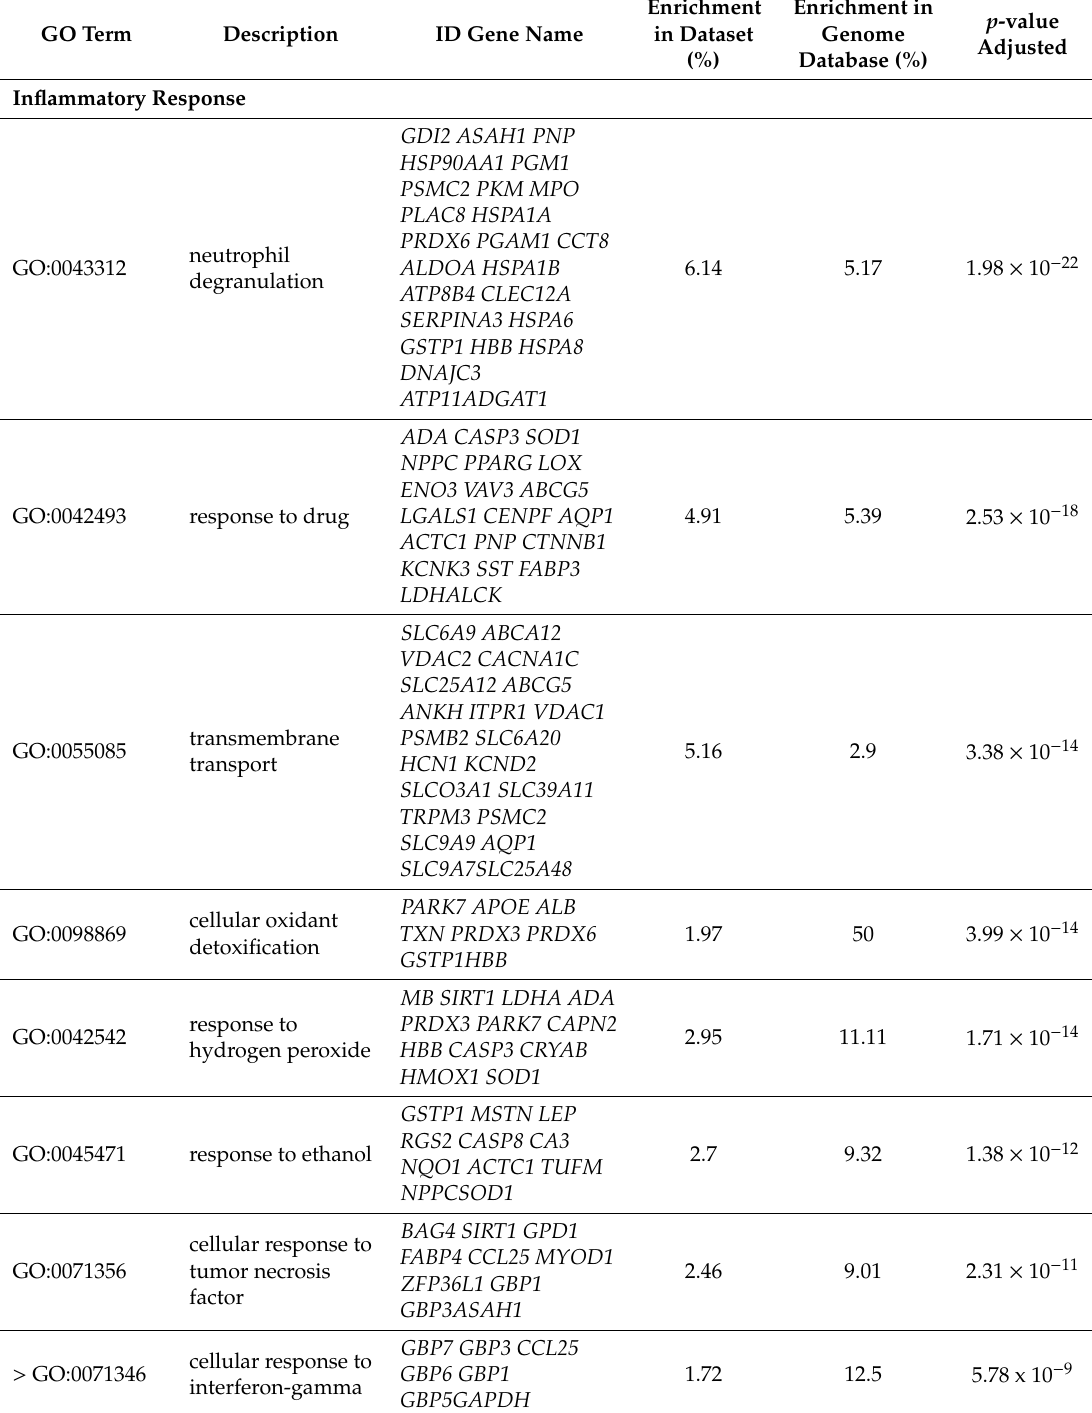
Table 3. TOP50 Gene Ontology terms associated with the 469 proteins of the aggregated dataset related to meat